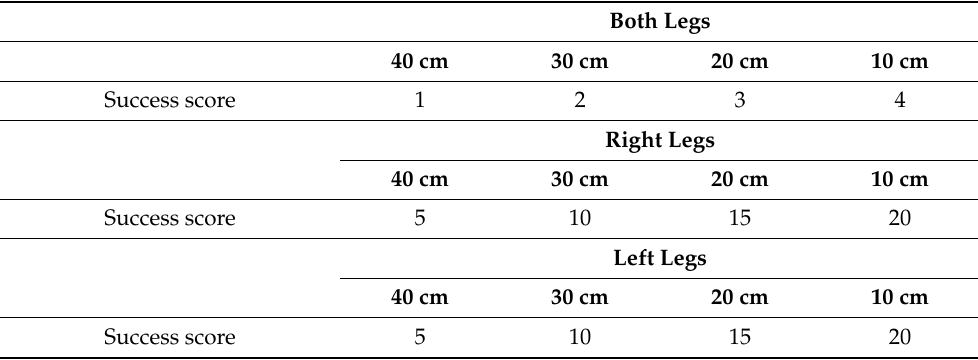
Table 1. Success score of the stand-up